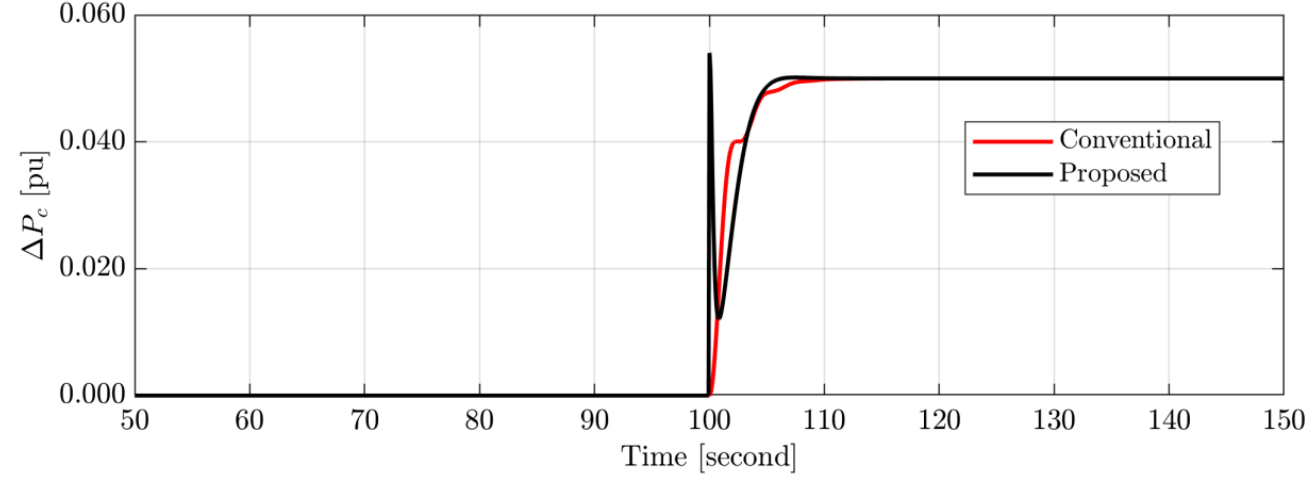
Figure 9. The output signals of the applied control techniques for the case 1.